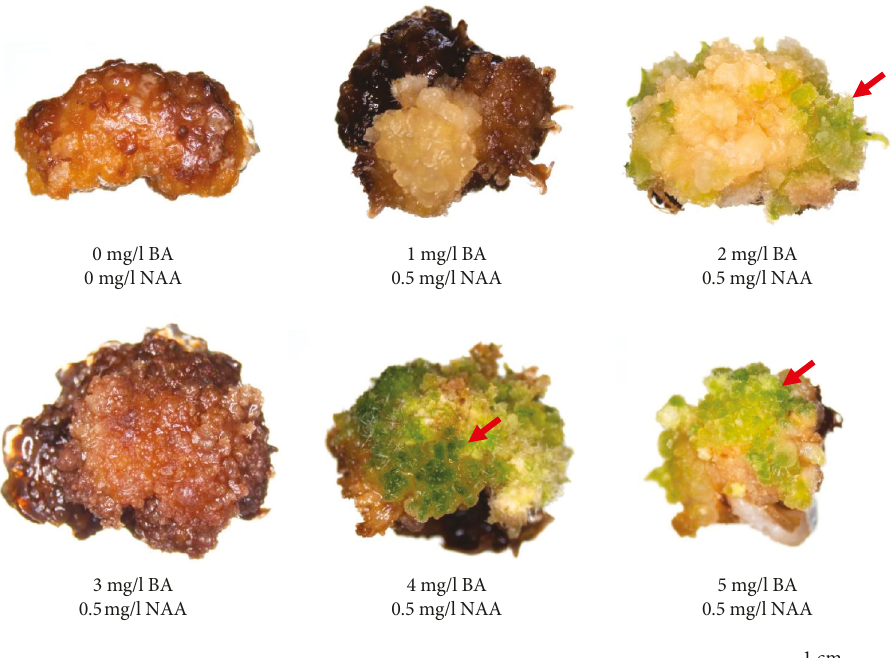
Figure 2: Callus features after culture on MS medium containing various BA and NAA concentrations for four weeks, 0.5mg/l NAA with 2, 4, and 5mg/l BA exhibited green spot formation (arrows).